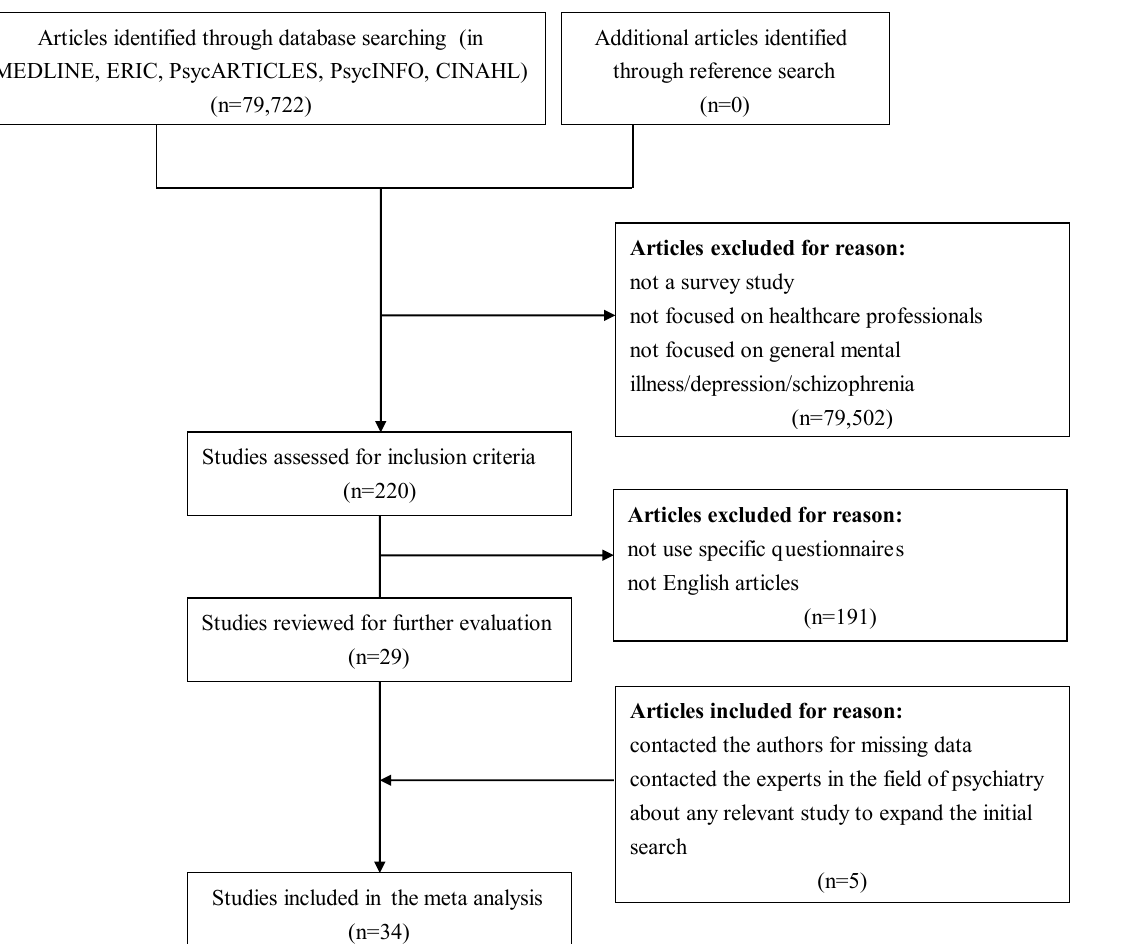
Figure 1. Flowchart of study selection. Table 1. Summary of characteristics of the 18 Social Distance Scale (SDS) studies.